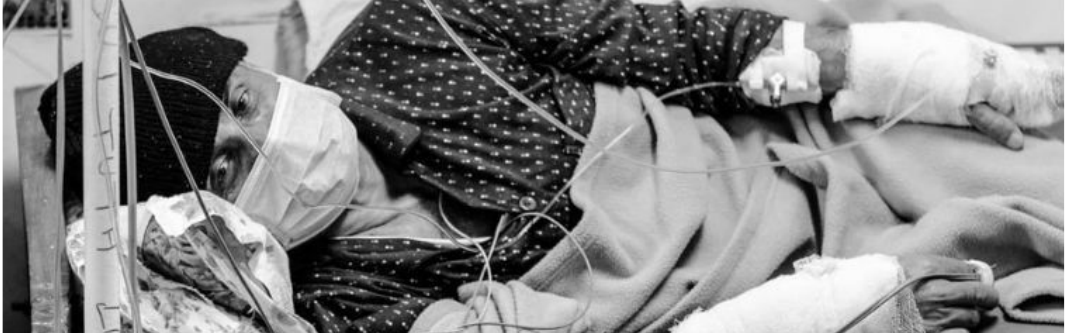
Figure 3. Dr. Govinda K. C. on a fast-unto-death in protest of Nepal’s medical education system. Source: